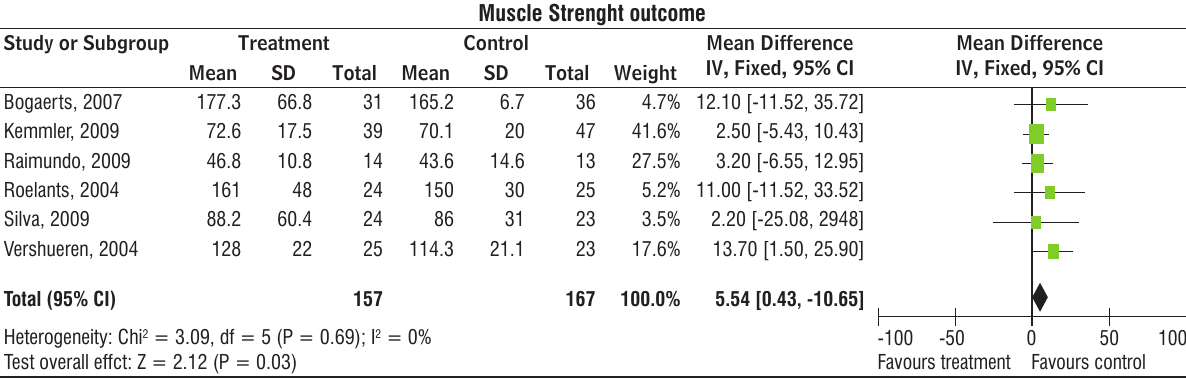
Quality of Life